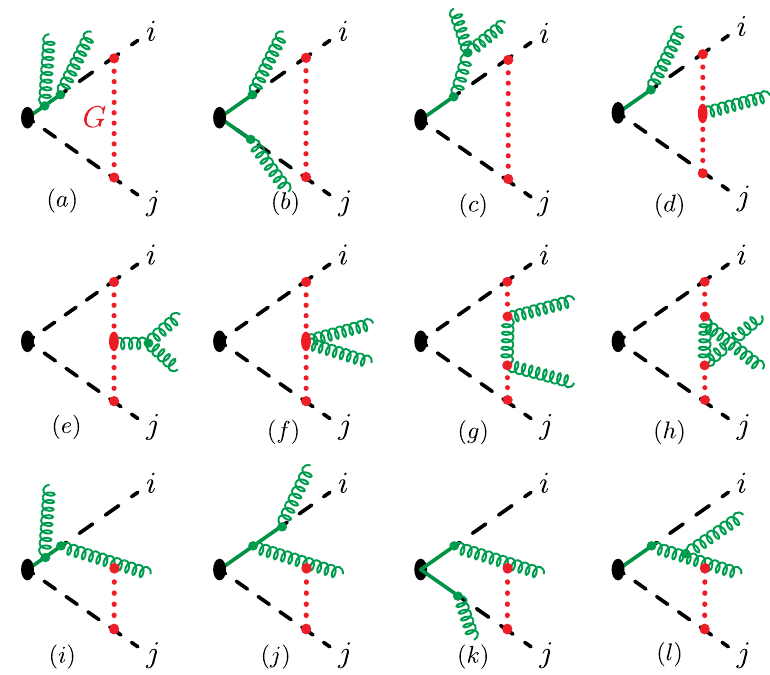
Figure 5 . One loop double soft emission graphs with a Glauber exchange. Additional diagrams are obtained by considering attachments to other collinear